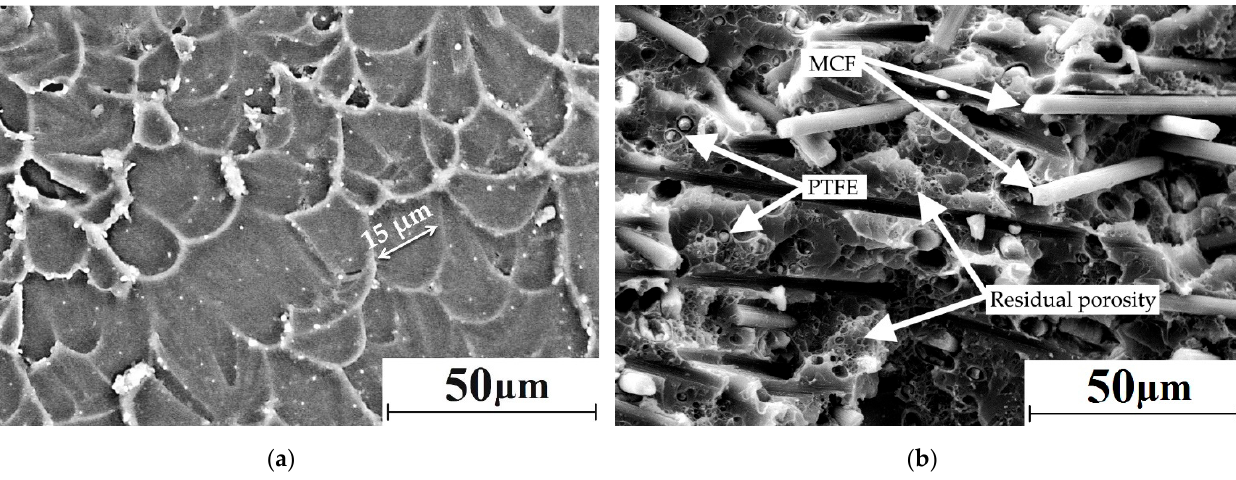
Figure 4. The SEM micrographs of the bulk structure: ( a ) neat PI; ( b ) the “PI/PTFE/MCF”